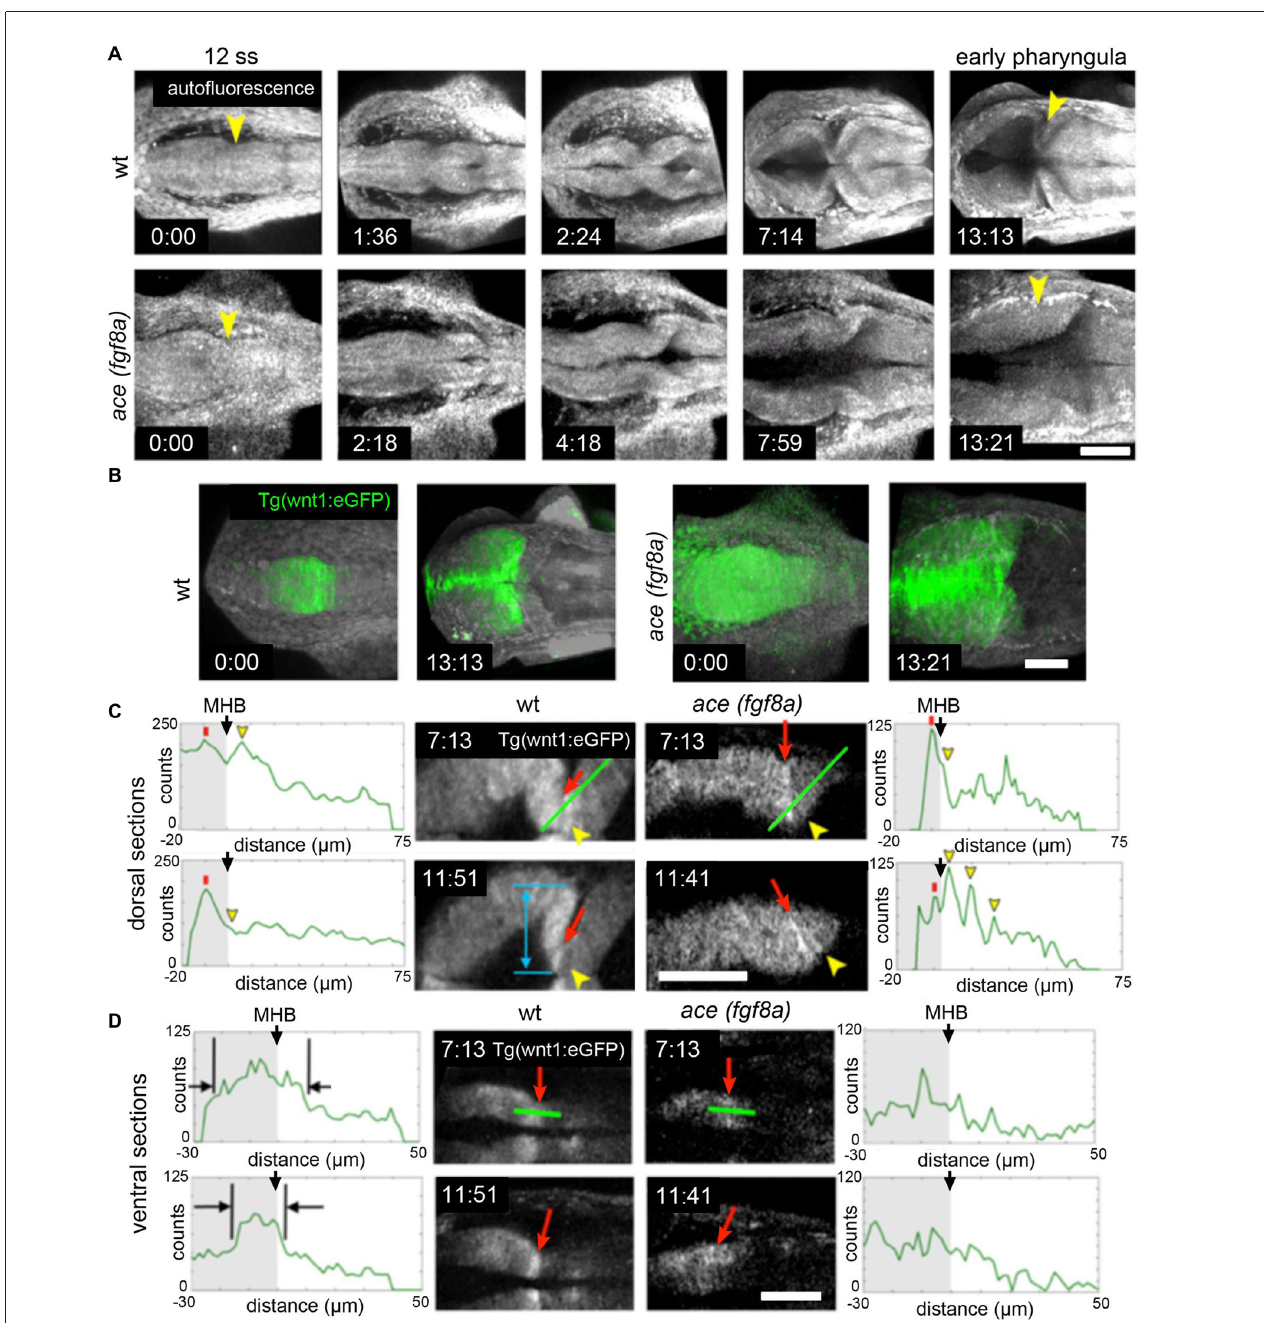
FIGURE 2 | Region dependent wnt1 reporter response in ace(fgf8a) background. (A) 3-D reconstructions generated using maximum intensity projection from tissue autofluorescence (with sections from the roof plate removed) reveal the formation of an isthmic constriction (yellow arrowheads) that fails to mature without fgf8a . (B) wnt1 lineage is present but improperly polarized in ace embryos. During normal development, the wnt1 lineage increases expression of wnt1 that can be visualized by increased eGFP reporter signal at the MHB boundary. (C) The wnt1 lineage in the dorsal neuroepithelium normally turns off expression of wnt1 in the anterior hindbrain as reflected by a decrease in reporter intensity (measured from the profiles marked by green lines over time). Red arrows point to a midbrain cell just anterior to the MHB constriction and yellow arrowheads point to a neighboring cell posterior to the constriction. The blue arrow shows the presumptive peripheral midbrain layer (PML). In ace(fgf8a) embryos, the constriction relaxes and neighboring cells in r1 begin re-expressing wnt1 as shown by increasing reporter intensity, reflecting a cerebellar-to-tectal transformation. Basal constriction of the boundary cells with highest wnt1 reporter intensity occurs in both cases, however, the presumptive PML fails to form in ace(fgf8a) embryos. (D) The wnt1 lineage in the ventral neuroepithelium normally undergoes cell shortening and compresses to a narrow ring of cells anterior to the physical MHB constriction (black markers) while in ace(fgf8a) embryos, this reorganization fails to occur and wnt1 is no longer expressed. Scale bar = 100 µ